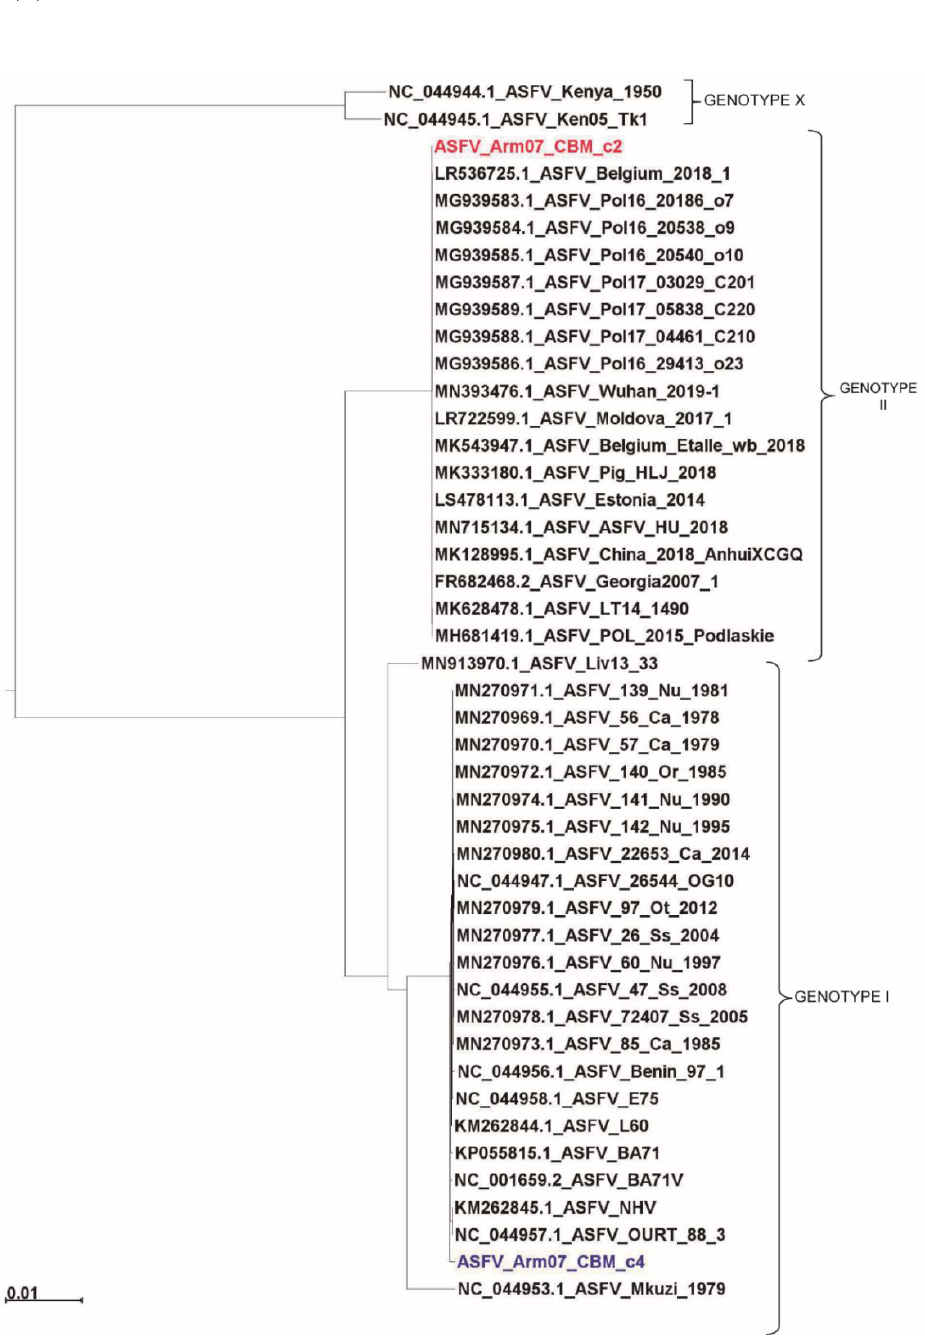
Figure 4. Phylogenetic tree of different ASFV genotypes built by maximum-likelihood method using sequences corresponding to the central conserved region (CCR, comprising 129 kb between A224L and I196L genes). Arm/07/CBM/c2 (highlighted in red) is grouped within the genotype II strains while Arm/07/CBM/c4 (highlighted in blue) is grouped within the genotype I strains. The tree was built based on MAFFT aligned genomes using IqTree software. Automatic settings were used, resulting in the selection of HKY+FK3PU+F+R2 as the best fit model; statistical support of the shown branches was obtained with an ultrafast bootstrap repetition value of 10,000. Substitution per base rate is indicated in the scale below.